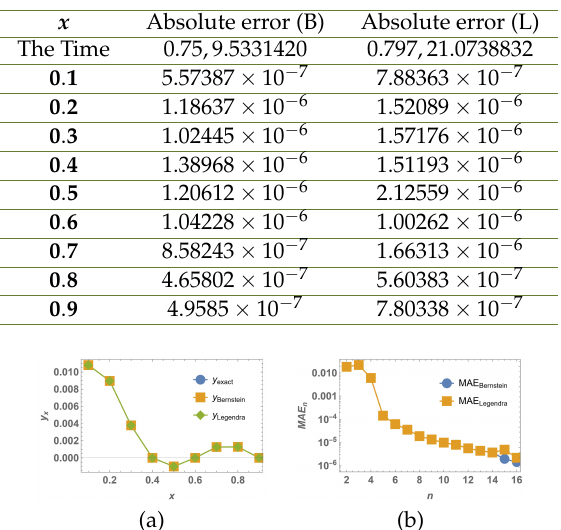
Table 1. The absolute error LOM) methods for example 1 at n=16